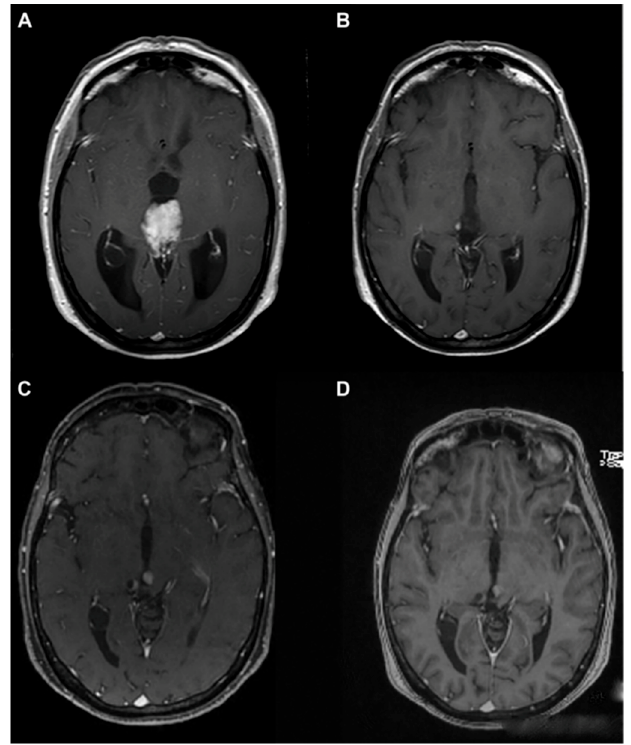
Figure 9. Pineal parenchymal tumors of intermediate differentiation MRI. Preoperative MRI ( A ), postoperative MRI showing a very small residual pineal lesion ( B ). MRI before ( C ) and after ( D ) radiation therapy. Reprinted with permission from Choque- Velasquez et al. (2019) [102]. Elsevier—2021 (License Number: 5035440109275). Pineal parenchymal tumors of intermediate differentiation may